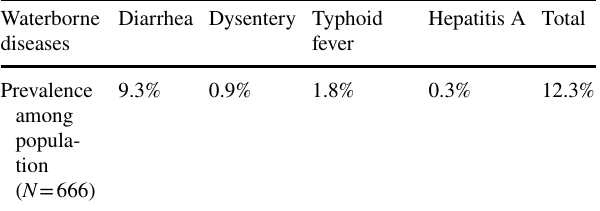
Table 9 Prevalence of waterborne diseases among the study popula- tion Waterborne diseases